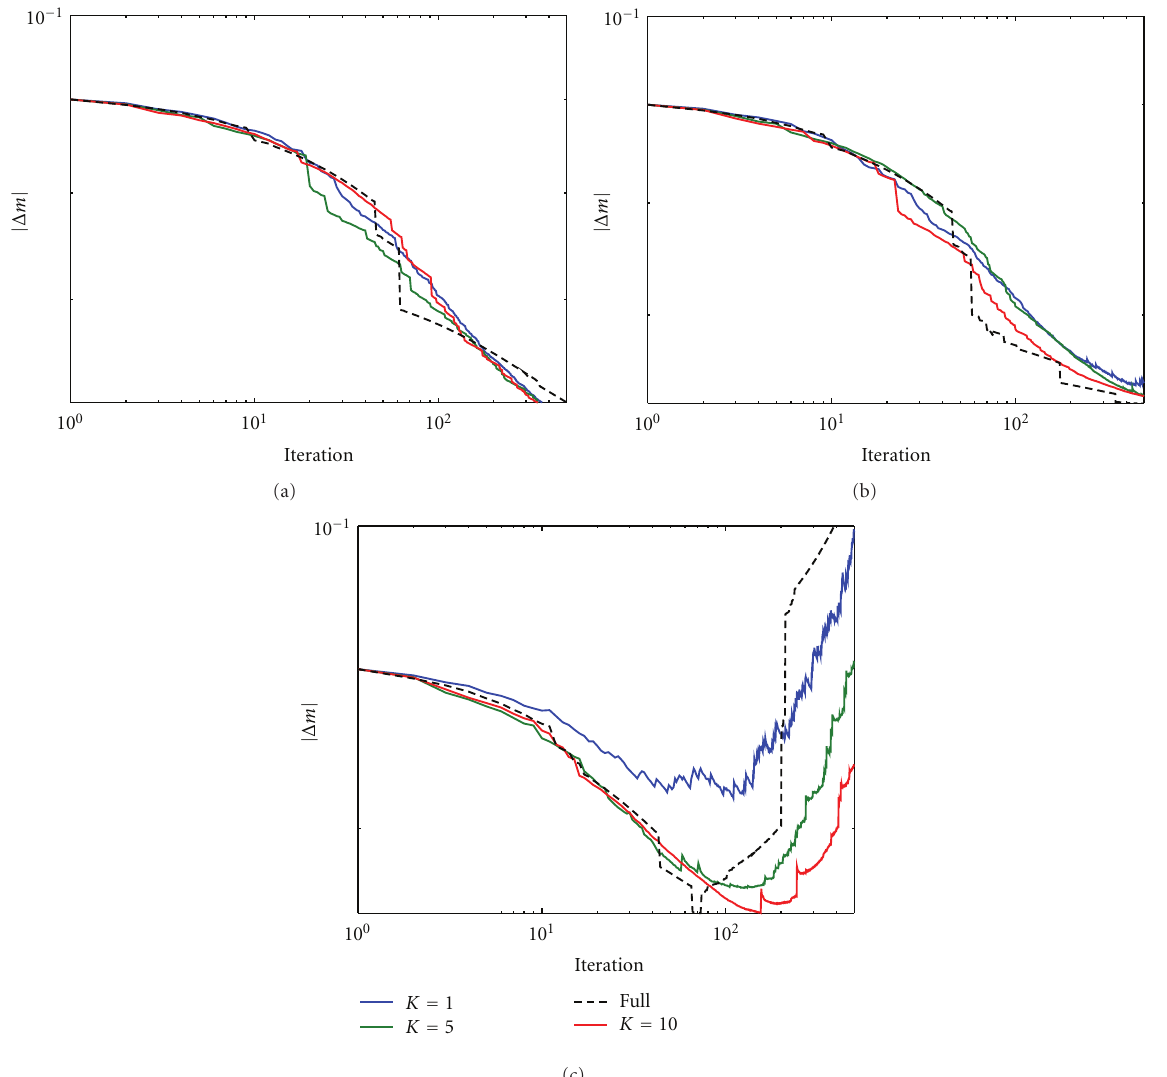
Figure 10: Error between the inverted and true model for the SA approach without averaging for various batch sizes and the full problem, (a) without noise, (b) with noise (SNR = 20dB), and (c) with noise (SNR = 10 dB). We get qualitatively similar results, compared to the full inversion, with K = 1 for noiseless data and data with 10 dB of noise. For very noisy data (20dB), we need a larger batch size. Although the SA approach requires roughly the same number of iterations as the full inversion, the iterations are much cheaper. For K = 1, we model the data for only one simultaneous source per iteration, compared to 61 for the full